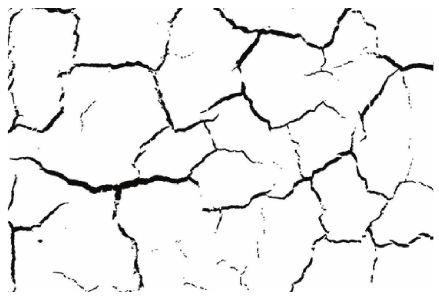
Figure 5: Binarization image of